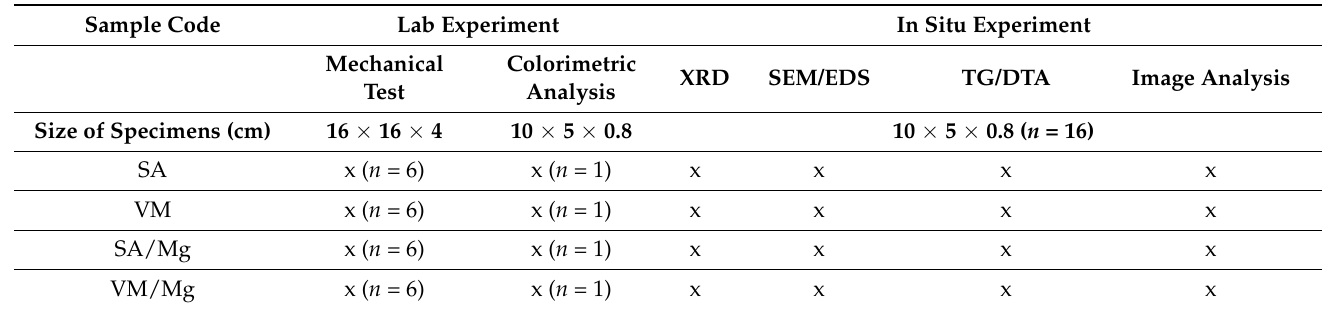
Table 1. Summary of the specimens used in the two experimental sets, with a brief description and analytical techniques used.